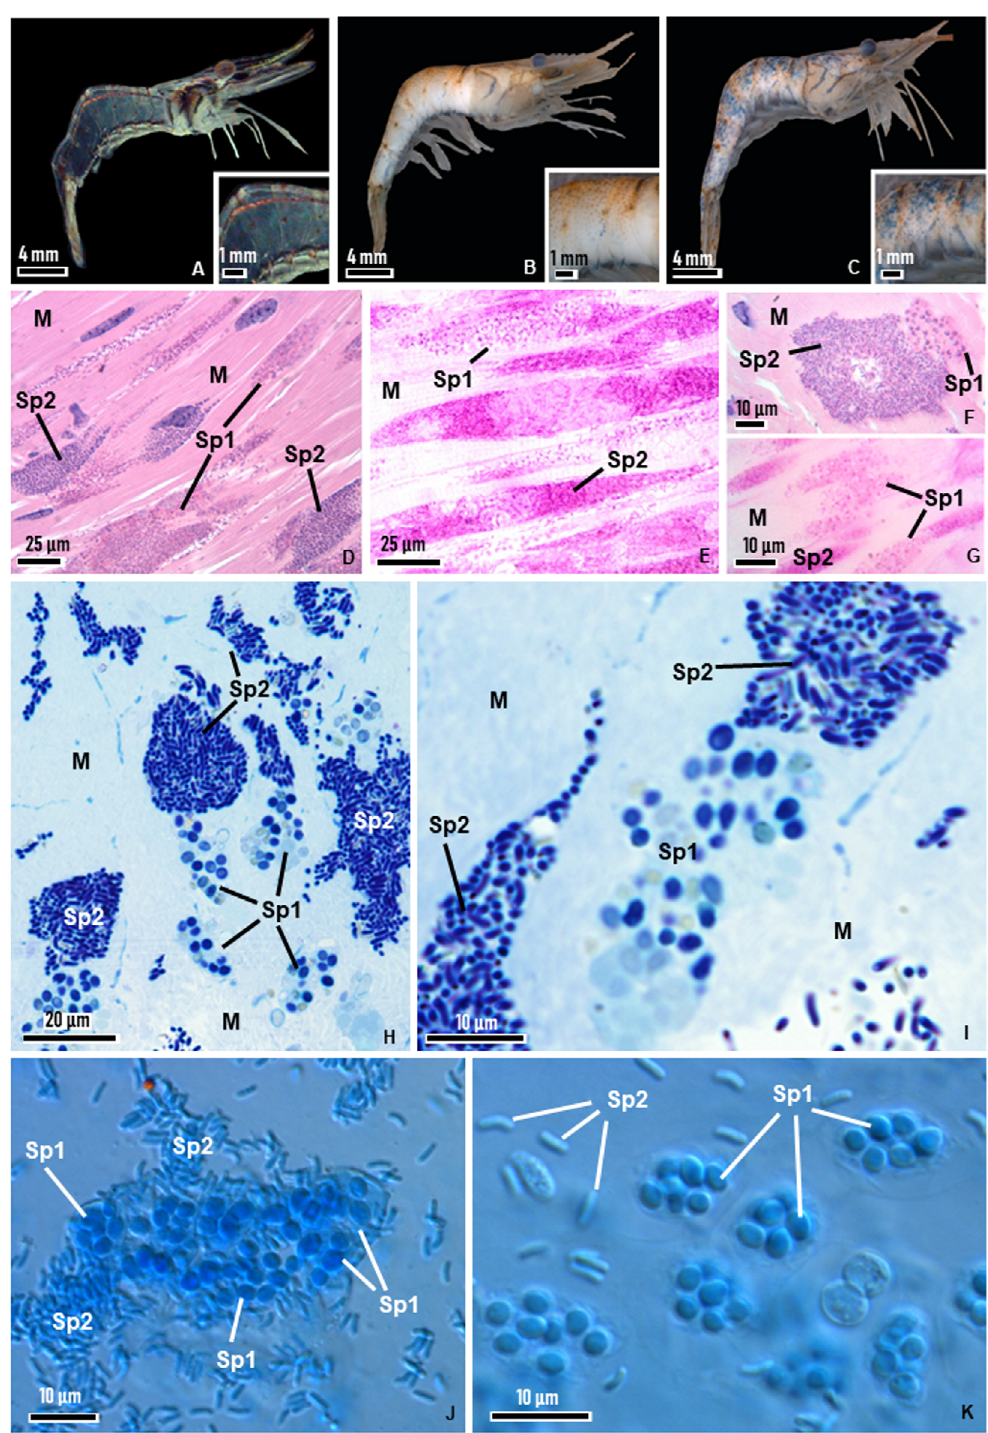
Figure 1. Macroscopic and light microscopy observations of microsporidians Inodosporus sp. and Myospora sp. infecting the abdominal muscles (M) of the Amazon River prawn Macrobrachium amazonicum : ( A ) The translucent appearance of an uninfected prawn. ( B , C ) Infected prawns showing opacity and whitening of the abdomen. Their chromatophores demonstrate abnormal color patterns, ranging from blue to orange (or both colors). Insets: Higher magnification of the abdominal area of the uninfected and infected prawns. ( D, E ) Spore clusters residing among muscle fibers: Inodosporus sp. (Sp. 1) and Myospora . sp. (Sp. 2). ( F, G ) Juxtaposed clusters of spores (Sp. 1 and Sp. 2). D and F: H&E; E and G: PAS. ( H, I ) Semi-thin sections showing distribution of Sp. 1 and Sp. 2 spore clusters. ( J ) A cluster composed of two spore morphotypes observed in DIC. Spores of the Sp. 1 are in the center of the cluster, while Sp. 2 spores are located at the periphery. ( K ) Isolated sporophorous vacuoles containing several spores of the Sp. 1 and free spores of the Sp. 2, observed in